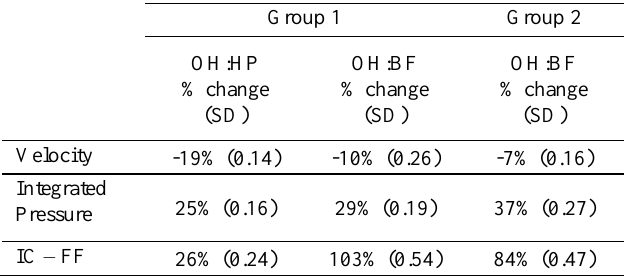
Table 1. Percent changes in data for Group 1 and Group